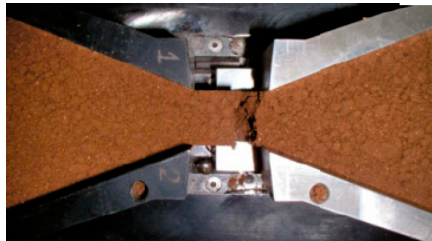
Figure 4. Clamp edge fracture (Lakshmikantha, 2009).